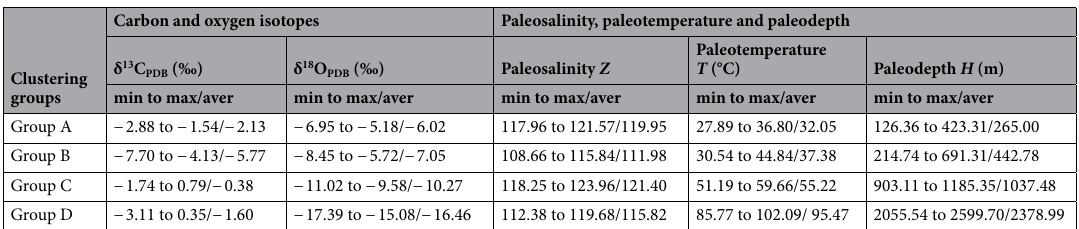
Table 2. Paleosalinity, paleotemperature, and paleodepth of the formation of the Ordovician carbonate paleokarst in Groups A, B, C, and D.